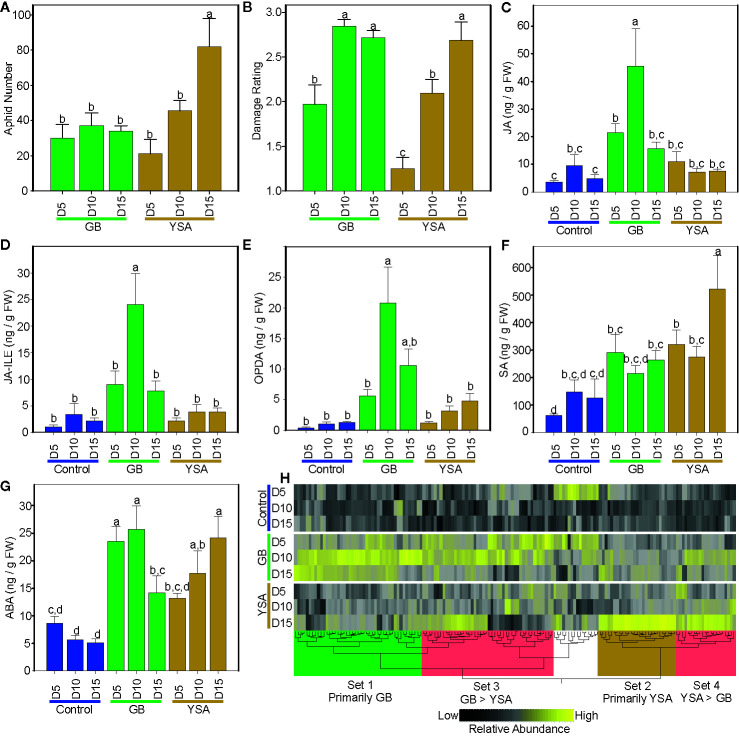
Changes in aphid numbers, plant damage and metabolites across three sampling dates. (A) Aphid numbers. (B) plant damage ratings. (C) Jasmonic acid (JA). (D) JA-isoleucine (JA-Ile). (E)12-Oxo-phytodienoic acid (OPDA). (F) Salicylic acid (SA). (G) Abscisic acid (ABA). (H) Metabolite heat map, black = low abundance, yellow = high abundance. In (A) to (G), green bars are from plants infested with greenbugs (GB), and gold bars are from plants infested with infested with yellow sugarcane aphids (YSA). In (C) to (G), blue bars are control uninfested plants. Different letters above bars in (A) to (G) denote significant differences at P ≤ 0.05, with separation of means using Fisher’s LSD. In all panels, days after initial infestation are shown as D5, D10, and D15. In (H), metabolites preferentially enriched in plants infested with GB (set 1, green box), in plants infested with YSA (set 2, gold box), and metabolites enriched in common in infested plants (sets 3 and 4, red boxes). Metabolite lists are provided in
Data S1
.